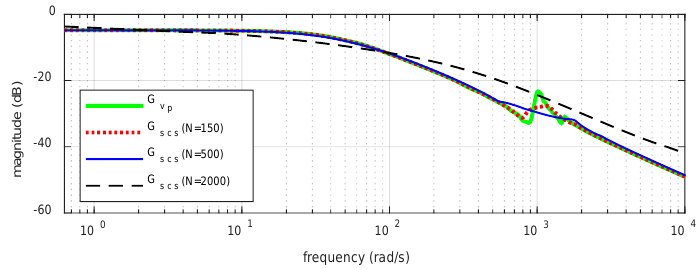
Figure 6. The magnitude plot of G vp and three cases of G scs with di ff erent N .